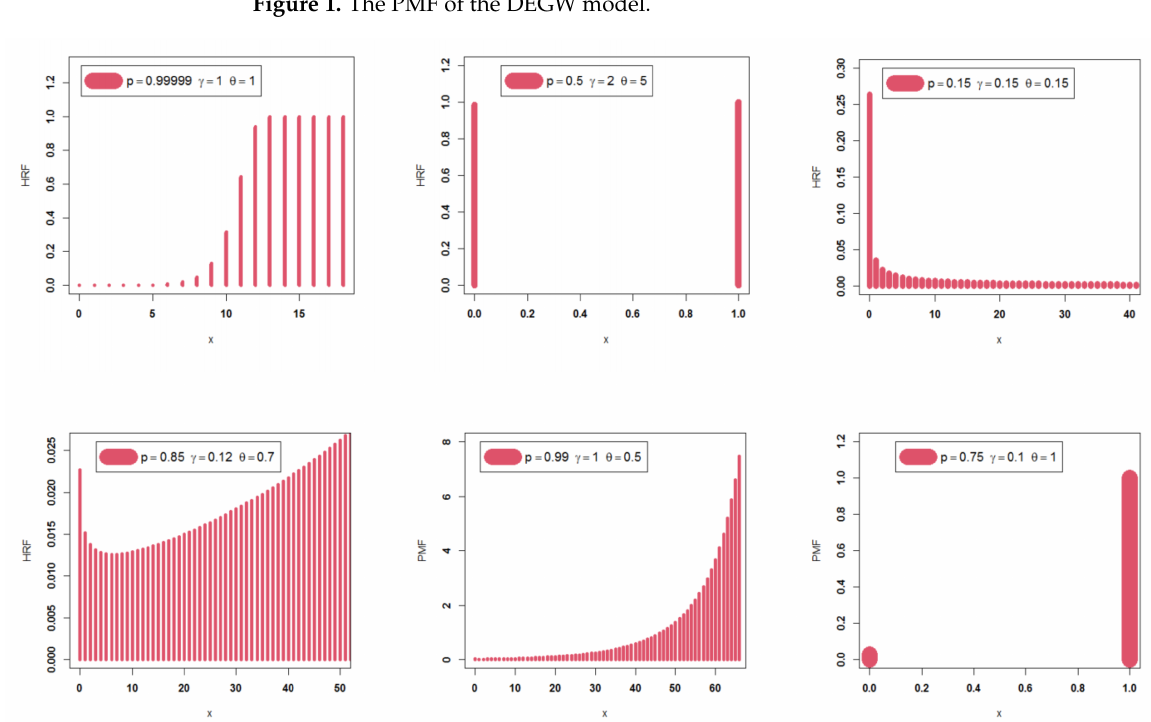
Figure 2. The HRF of the DEGW